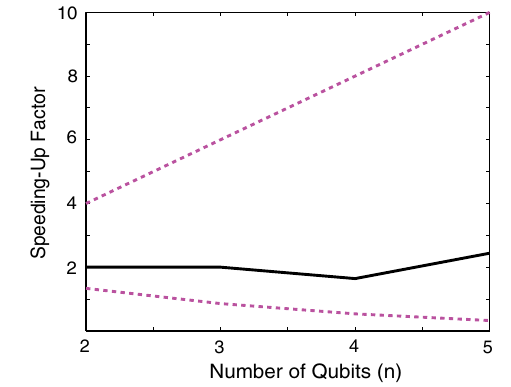
FIG. 16. Bounds on the asymptotic speeding-up for a register of qubits. The dashed magenta lines are the upper and lower bounds derived in the main text, Eq. (45). The solid line is the P X ð r Þ X ¼ max i;j is largest element of X r j i;j j . The element max max conjectured to be a good indicator for maximum achievable speeding-up with the QFT in a register of